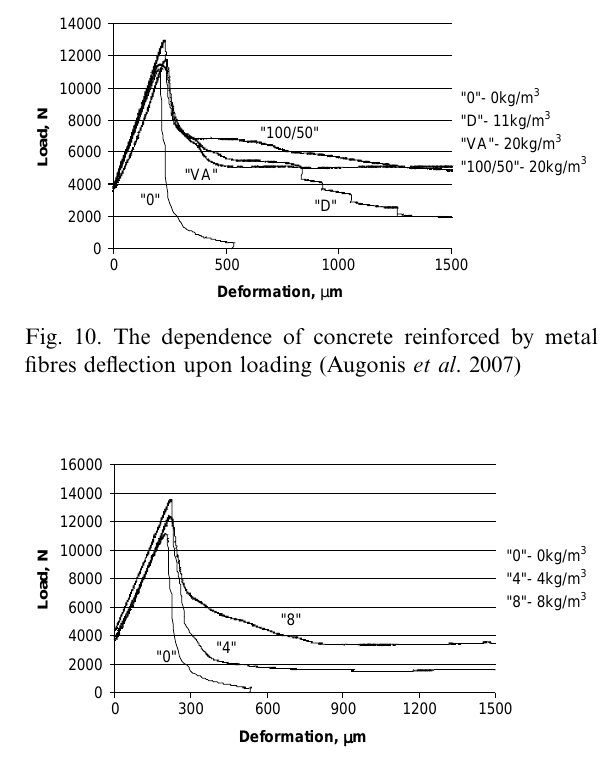
Fig. 11. The dependence of concrete reinforced by poly- propylene fibres deflection upon loading (Augonis et al